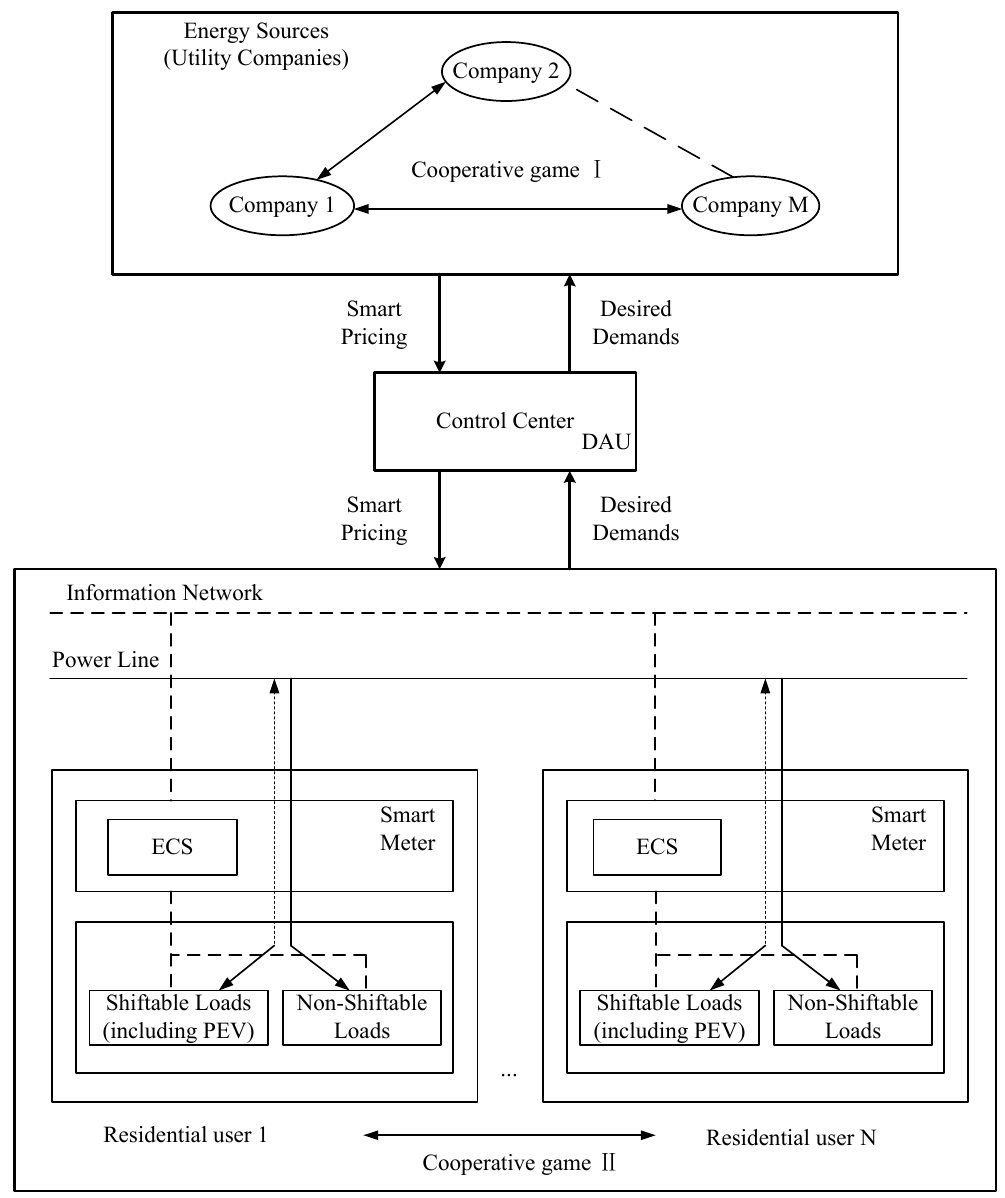
(cid:3) Figure 1. An energy management scenario with multiple utility companies and multiple residential users in a smart grid (SG). DAU: data aggregation unit; ECS: energy consumption scheduling; and PEV: plug-in electric